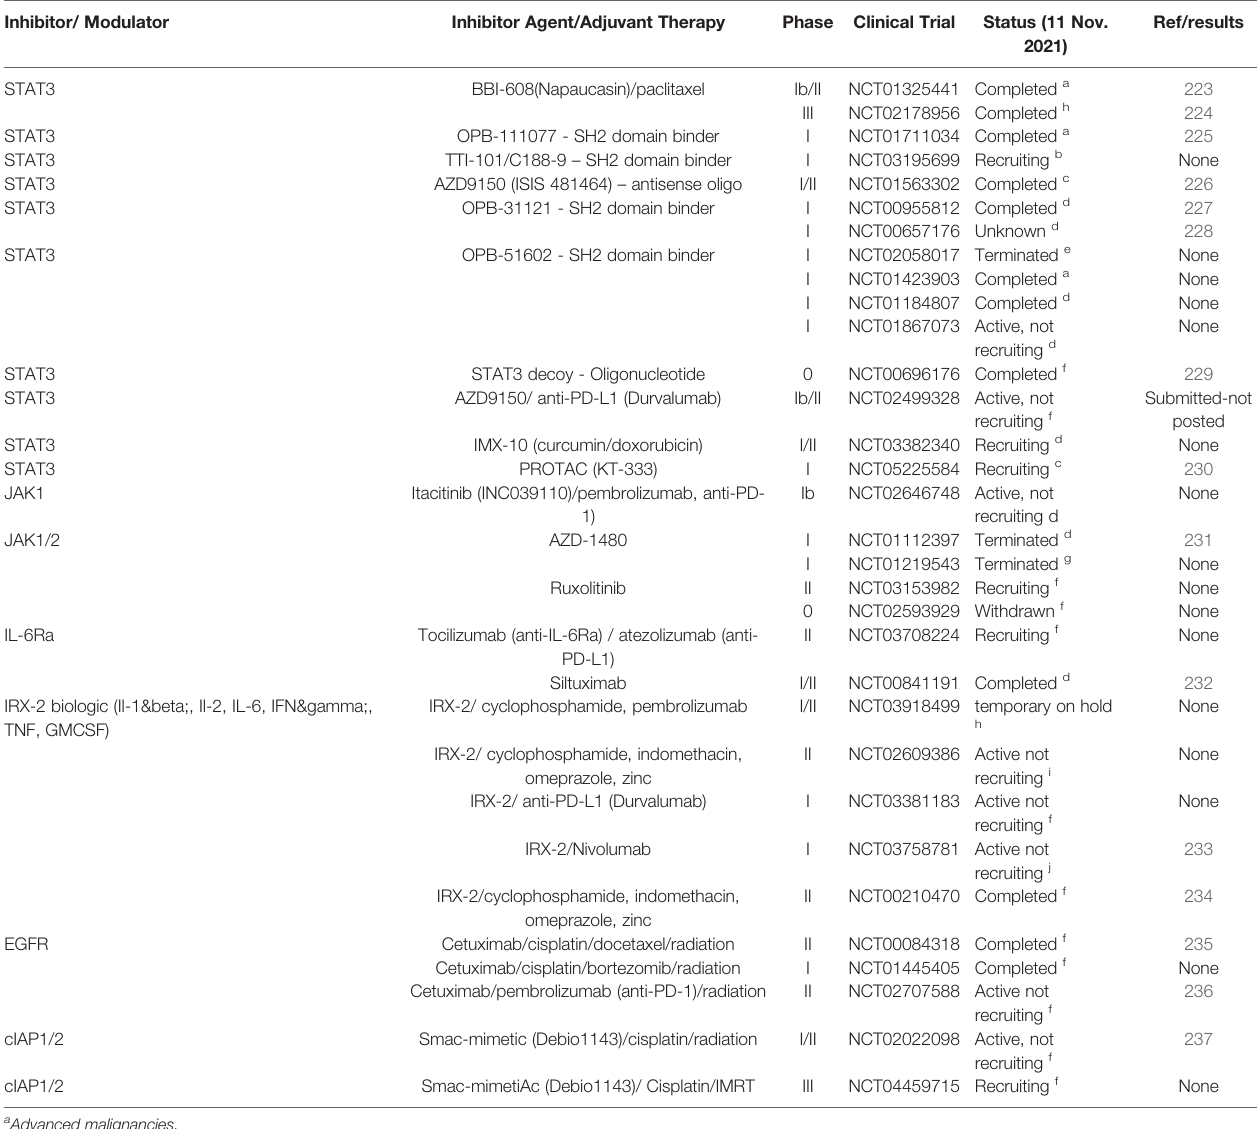
TABLE 1 | Clinical Trials for JAK-STAT/TNF Pathway modi fi ers in HNSCC or